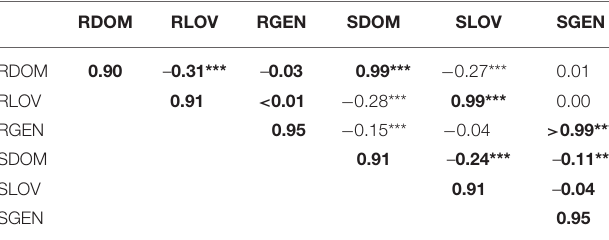
TABLE 4 | Correlations between higher-level scores of the inventory of interpersonal problems and reliability estimates.